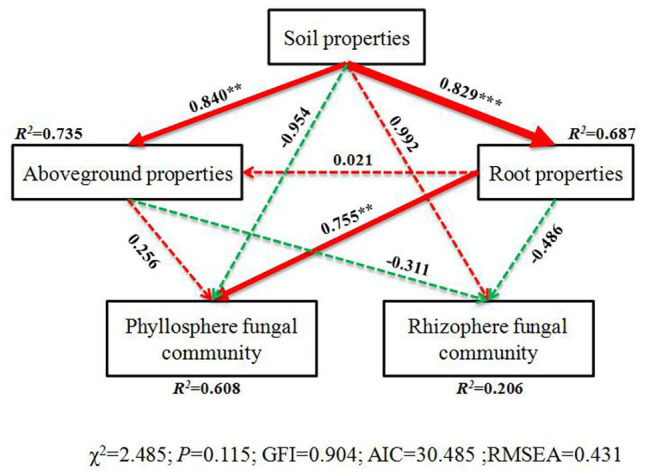
Structural equation model (SEM) illustrating the effects of soil properties on physicochemical characteristics (aboveground and root) and fungal communities of phyllosphere and rhizosphere. Continuous and dashed arrows represent the significant and non-significant relationships, respectively. Adjacent numbers that are labeled in the same direction as the arrow represents path coefficients, and the width of the arrow is in proportion to the degree of path coefficients. Green and red arrows indicate positive and negative relationships, respectively. R2 values indicate the proportion of variance explained by each variable. Significance levels are denoted with **p < 0.01 and ***p < 0.001. Standardized total effects (direct plus indirect effects) calculated by the SEM are displayed below the SEM. The low chi-square (χ2), nonsignificant probability level (p > 0.05), high goodness-of-fit index (GFI > 0.90), low Akaike information criteria (AIC), and low root-mean-square errors of approximation (RMSEA < 0.05) listed below the SEMs indicate that our data match the hypothetical models.